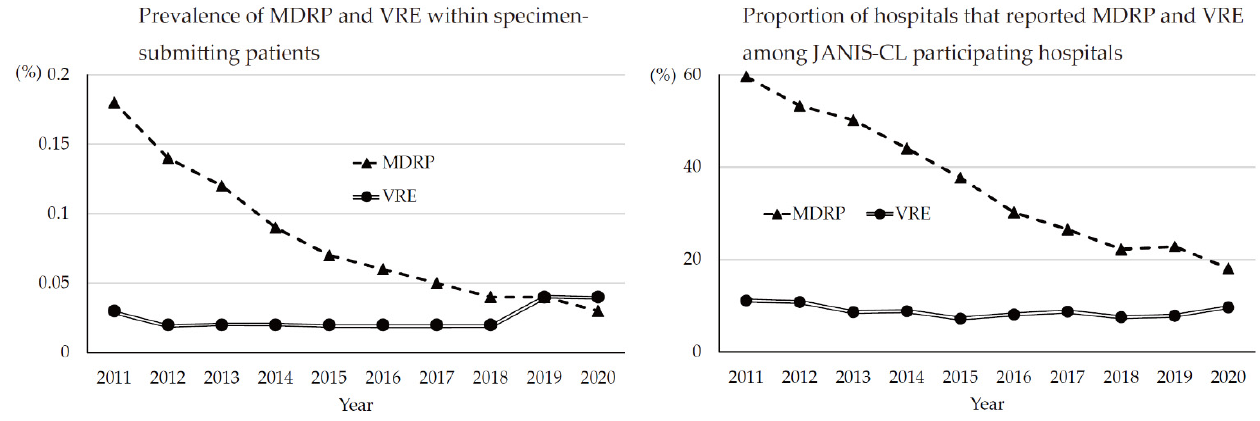
Figure 4. Trends of MDRP and VRE in JANIS-CL, 2011 to 2020.